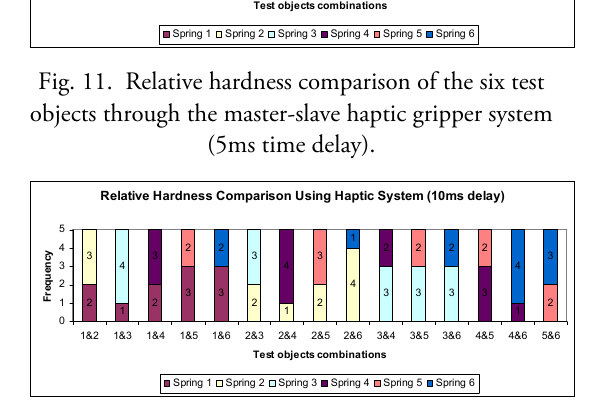
Fig. 12. Relative hardness comparison of the six test objects through the master-slave haptic gripper system (10ms time